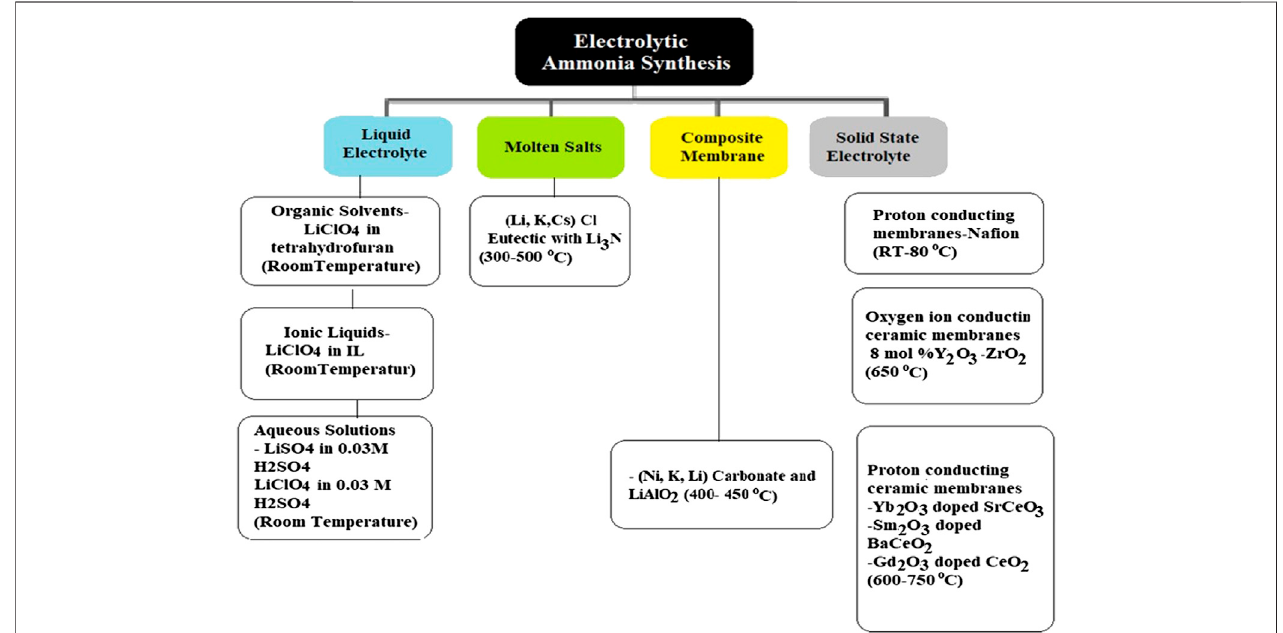
FIGURE 4 | Different electrolytic routes for ammonia